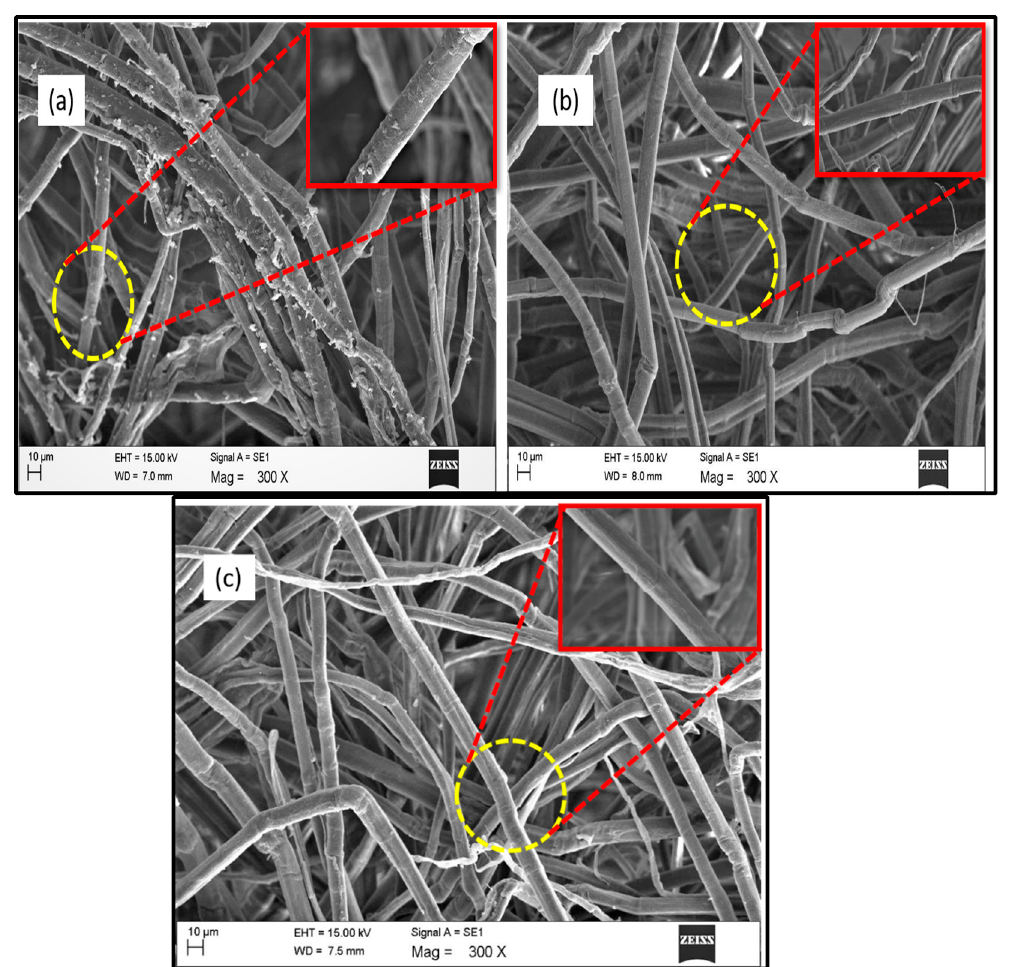
Figure 7. SEM images of ( a ) raw fiber, ( b ) alkali treated fiber, and ( c ) bleached fiber .